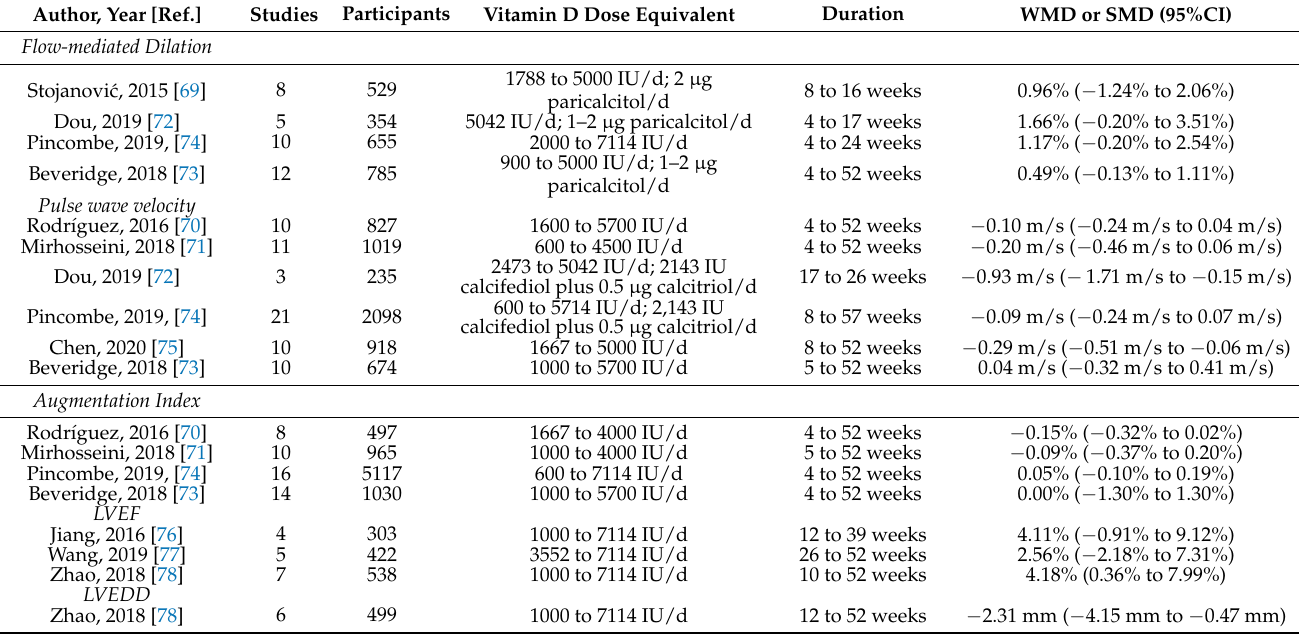
Table 2. Meta-analyses of randomized controlled trials on vitamin D supplementation and selected surrogate markers of cardiovascular